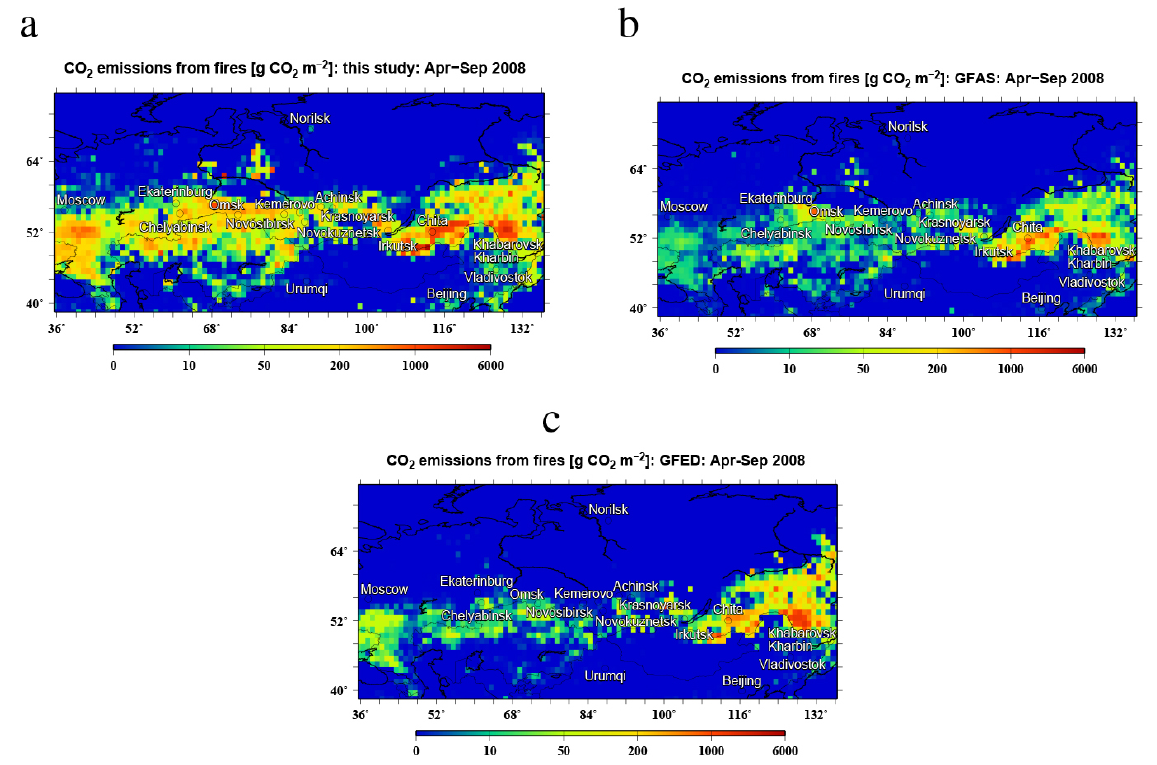
Figure 10. Spatial distribution of the total CO 2 emissions (gCO 2 m − 2 ) over the period April–September 2008: (a) this study, (b) GFASv1.0, and (c)